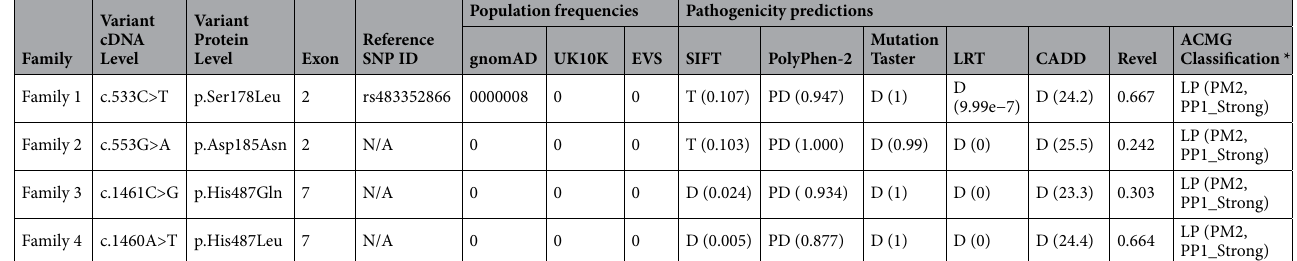
Table 2. Characteristics of TBC1D24 variants detected in this study. *ACMG classification criteria legend: LP likely pathogenic, PM moderate pathogenicity evidence, PP_Strong strong pathogenicity evidence, D damaging, N/A no data available, PD probably damaging, T